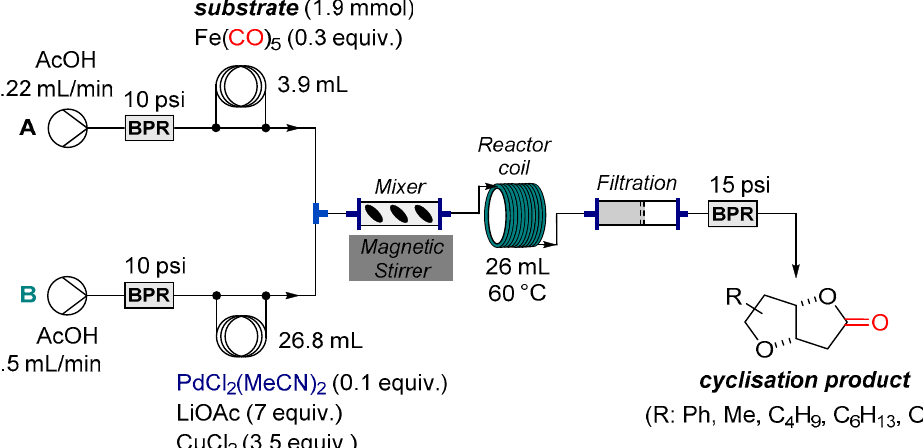
reaction Optional Equipment